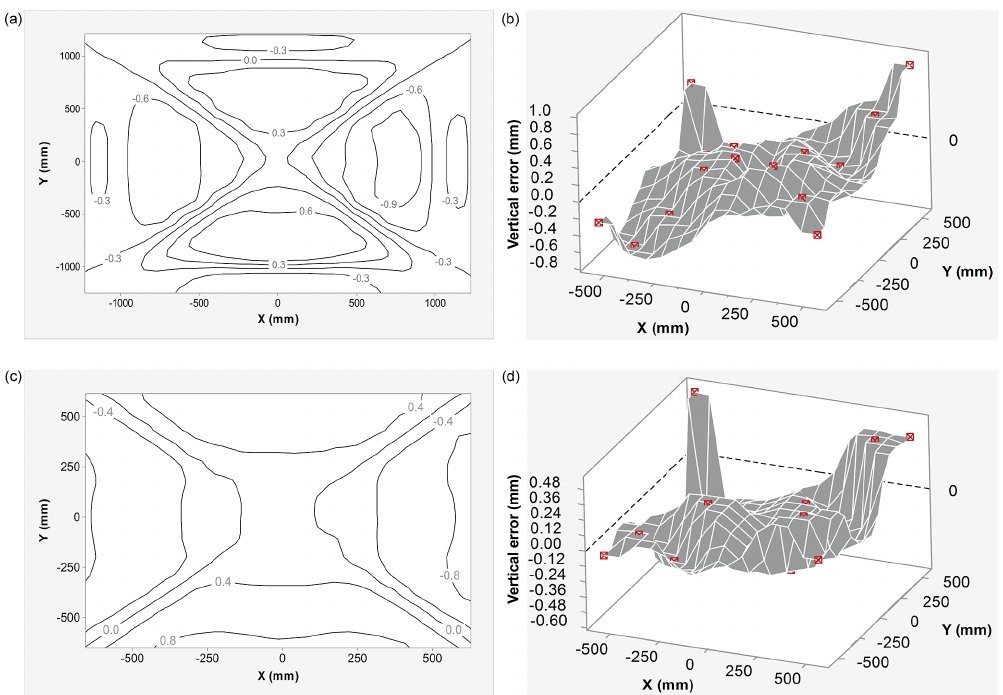
Figure 4. (a) Horizontal error contour plot for a DEM generated using images acquired with the zoom lens. Contours represent horizontal ( XY ) error (in mm) in the DEM. (b) Vertical errors in DEM generated using images from a zoom lens. Red cubes on the surface in the plot show the location of wooden blocks (vertical checkpoints). (c) Horizontal error contour plot for a DEM generated using images from a prime lens. Contours represent horizontal ( XY ) error (in mm) in the DEM. (d) Vertical errors in DEM generated using images from a prime lens. Red cubes on the surface in the plot show the location of wooden blocks (vertical checkpoints).